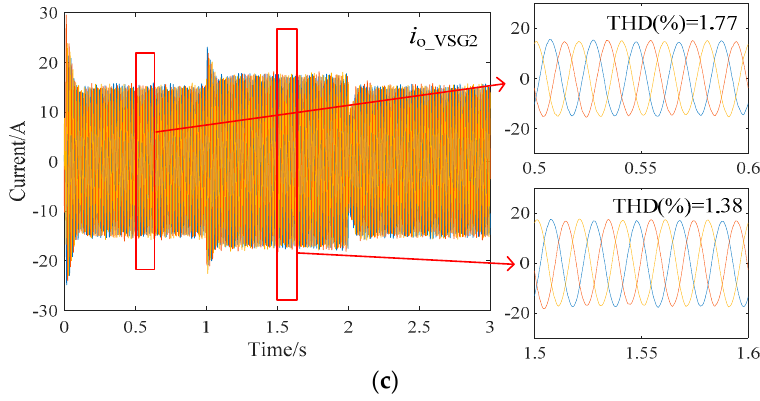
Figure 10. Output waveforms of VSG control to voltage deviation. ( a ) Without decoupling link; ( b ) With decoupling link; ( c ) Output current of VSG2 with decoupling link.